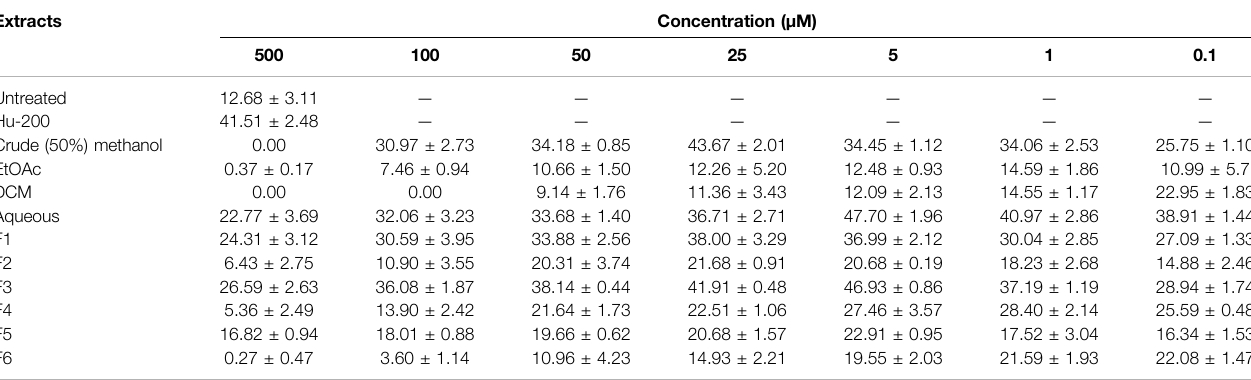
TABLE 2 | Erythroid differentiation effects of the crude extract and methanol fraction of A. vasica in a dose-dependent manner, with untreated culture as a negative control and HU as a positive control. Extracts Concentration (µM) 500 Untreated Crude (50%)